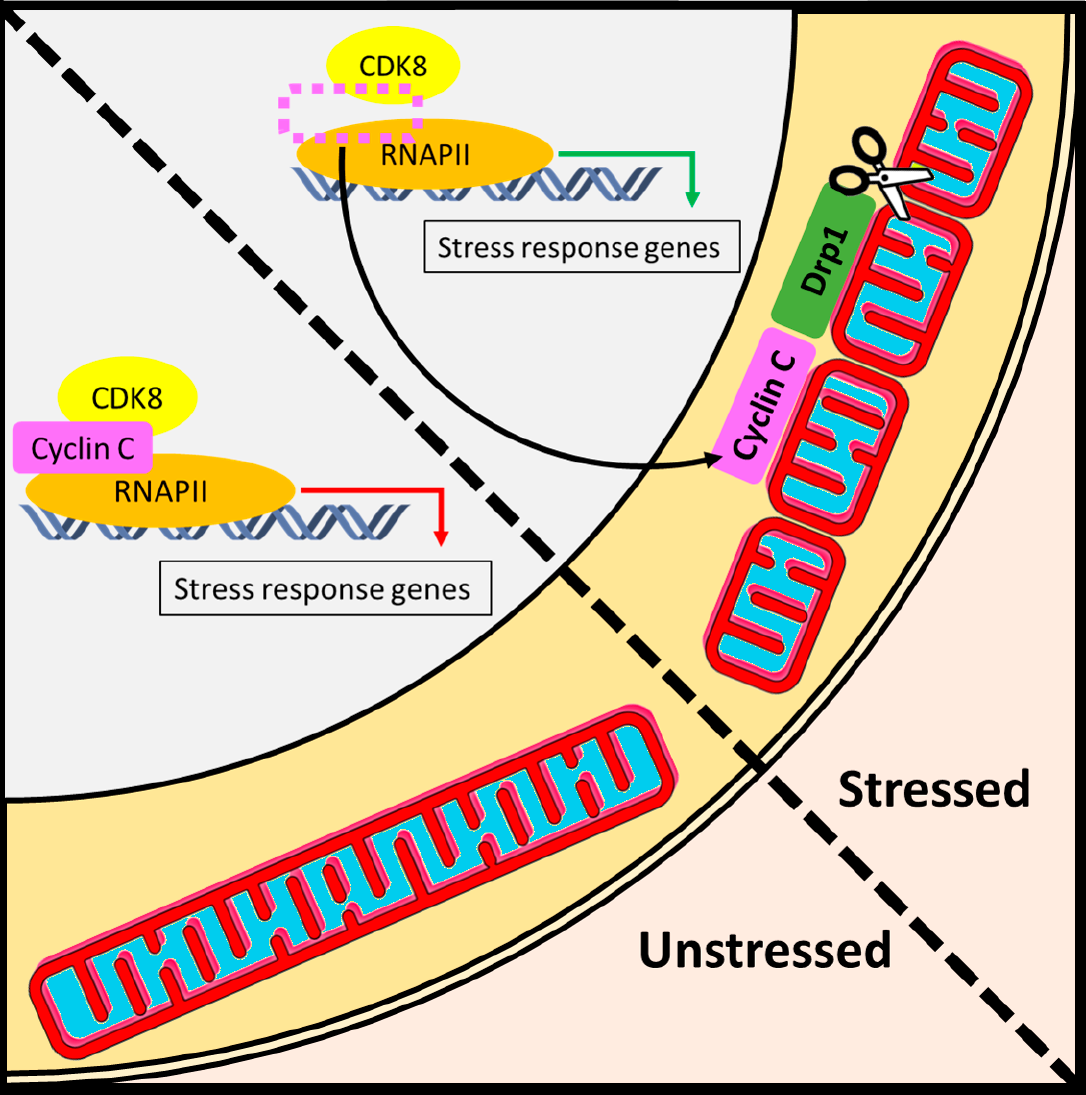
Figure 5. Day job versus night job function of cyclin C. ( Left ) Under normal conditions, cyclin C performs its day job as a nuclear transcription factor that regulates RNA Pol II-dependent activity. In unstressed cells, mitochondria maintain a reticular structure [33]. ( Right ) The night job function of cyclin C is initiated by cellular stress and is associated with the activation of two layers of stress defense. First, under adverse conditions such as oxidative stress, a portion of cyclin C exits the nucleus to induce Drp1-dependent mitochondrial scission. The resulting fragmentation of mitochondrial network facilitates downstream stress responses such as mitophagy or apoptosis. Second, upon dissociation of cyclin C from the promoters of stress response genes, the activity of RNA Pol II is regained, which triggers a host of adaptive mechanisms such as antioxidant defense or unfolded protein response.